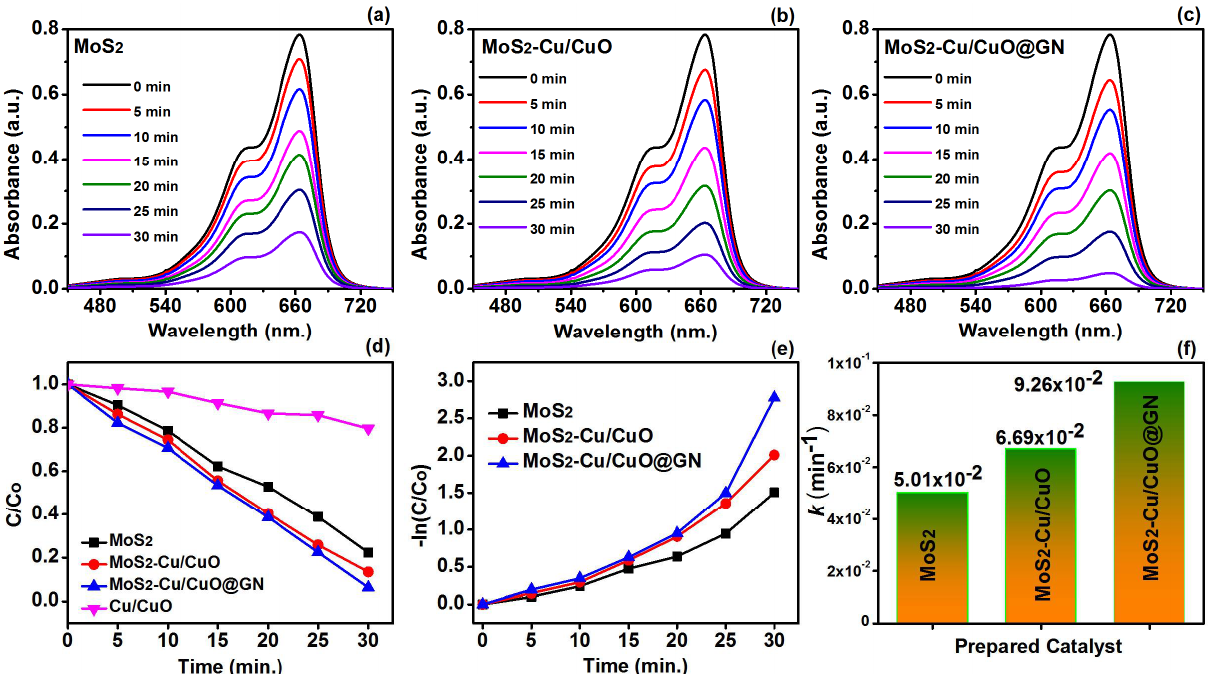
Figure 7. ( a – c ) Time-dependent dilapidation of the MB characteristic peak in the presence of Cu/CuO, MoS 2 , MoS 2 -Cu/CuO and MoS 2 -Cu/CuO@GN, ( d , e ) degradation percentage rate of MB within 30 min and ( f ) reaction rate constant of MoS 2 , MoS 2 -Cu/CuO and MoS 2 -Cu/CuO@GN.